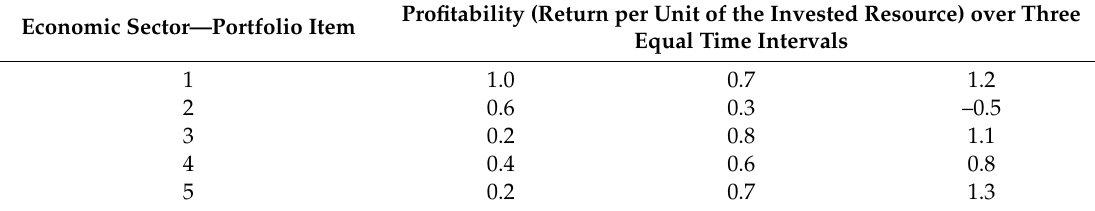
Table 1. Portfolio of five economic